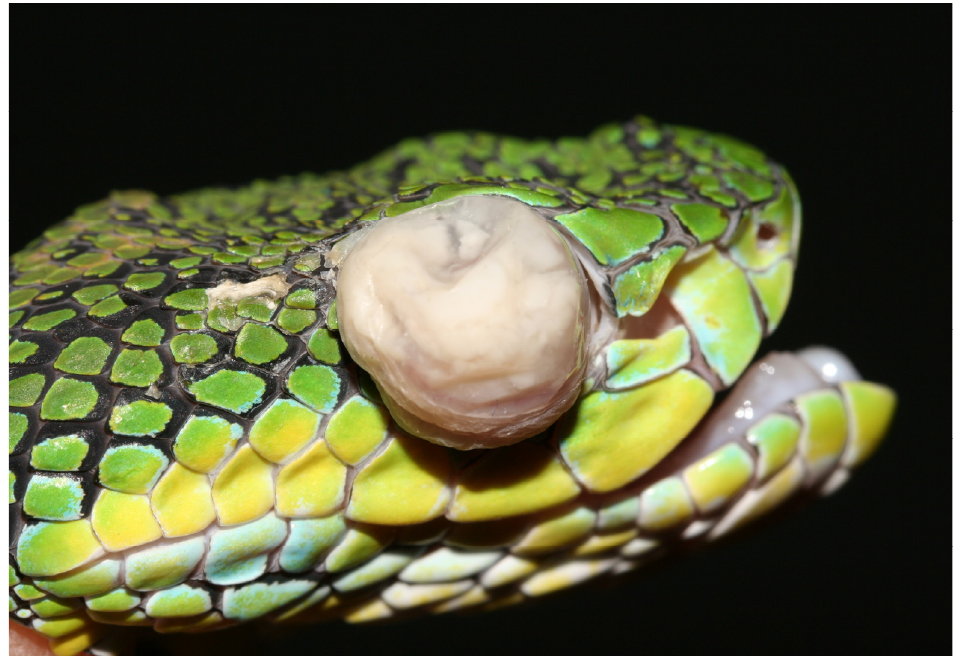
Figure 34. Extremely chronic subspectacular abscess in a Schultze’s pit viper ( Trimeresurus schultzei ). Avulsion of the spectacle may occur if manipulated because of the chronic inflammatory changes.